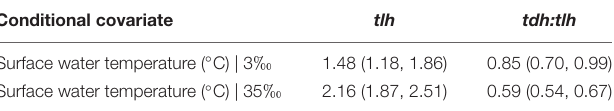
TABLE 5 | Relative change in geometric mean with corresponding 95% confidence intervals of surface water temperature ( < 22 ◦ C) conditioned on water salinity.